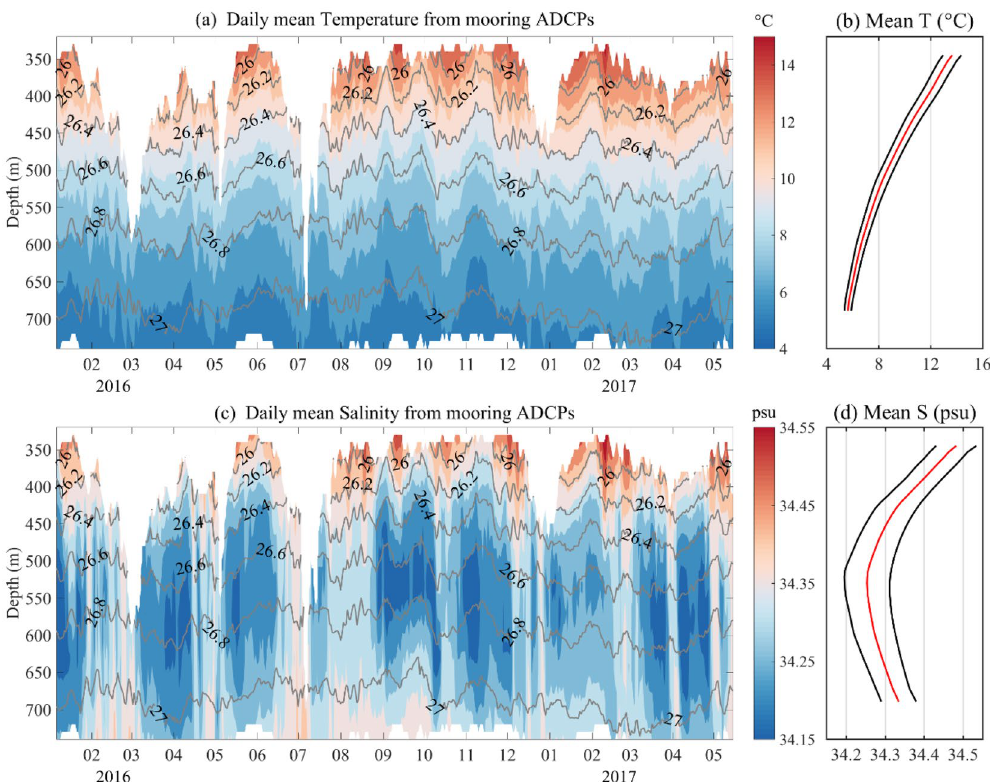
Figure 2. Time series of temperature and salinity from mooring observation. The daily mean of the CTD measurements of the temperature and salinity at depths from 350 to 800 m during the period from Jan 2016 to April 2017 in ( a , c ), respectively. Gray in ( a , c ) indicates the potential density calculated from temperature, salinity and depth data measured by the CTDs. The red lines in ( b , d ) indicate the means, and the black lines in ( b , d ) indicate the deviations of the temperature and salinity,